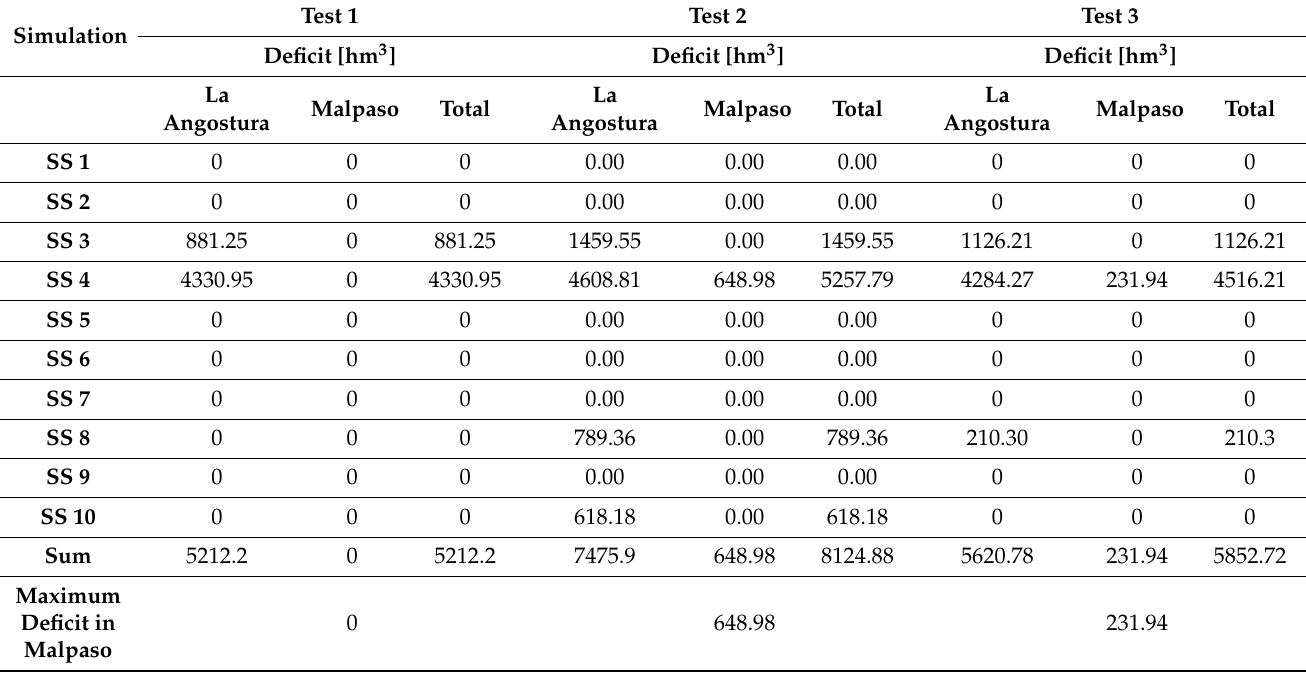
Table 7. Summary of the joint simulation of dams: La Angostura and Malpaso: deficit .